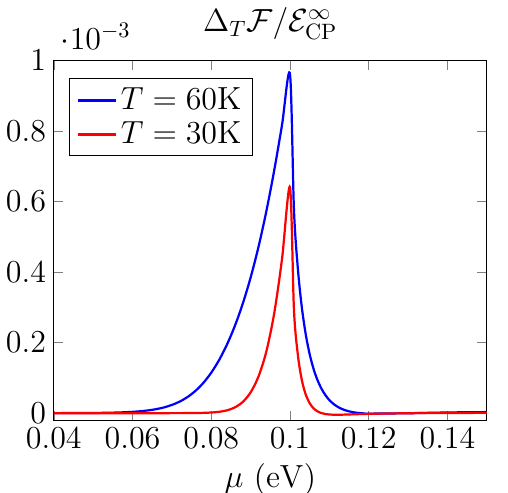
Figure 6. The temperature contribution to the free energy as a function of the chemical potential for distance between Hydrogen atom and graphene a = 100 nm. The point µ = m looks like a phase transition point between different regimes from ∆ 4 to ∆ 2 . In fact, it is an unstable point—infinitely small deviation µ from T F ∼ T T F ∼ T m changes